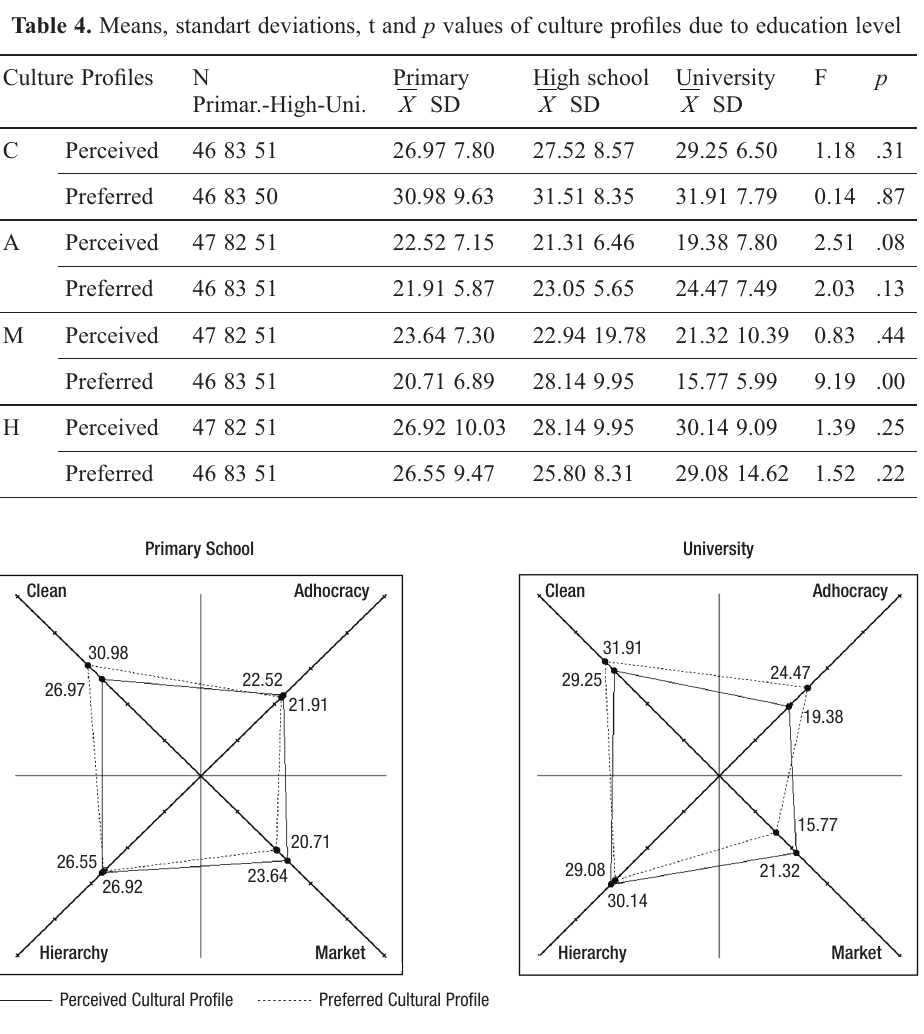
Fig. 4. Cultural profi le of graduates of primary school and university in headquarters